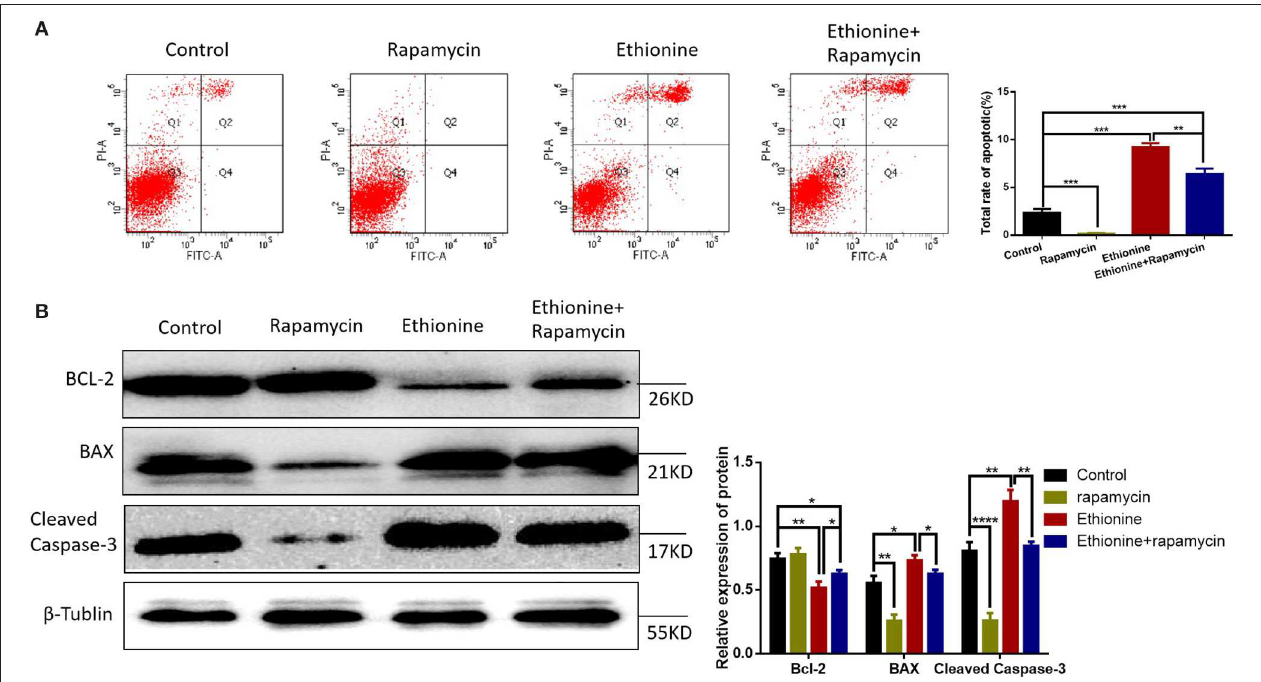
FIGURE 8 | Ethionine activated Caspase-3-dependent mitochondrial apoptosis. (A) HT-22 cells were treated with ethionine and rapamycin, the cell apoptosis was analyzed by flow cytometry. (B) BAX, BCL-2, and Cleaved Caspase-3 protein levels in control and experiment groups were evaluated via Western blotting. β -Tublin levels were also evaluated to confirm equal loading ( n = 3). Each experiment was carried out in triplicates, * P < 0.05, ** P < 0.01, *** P < 0.001, and **** P <